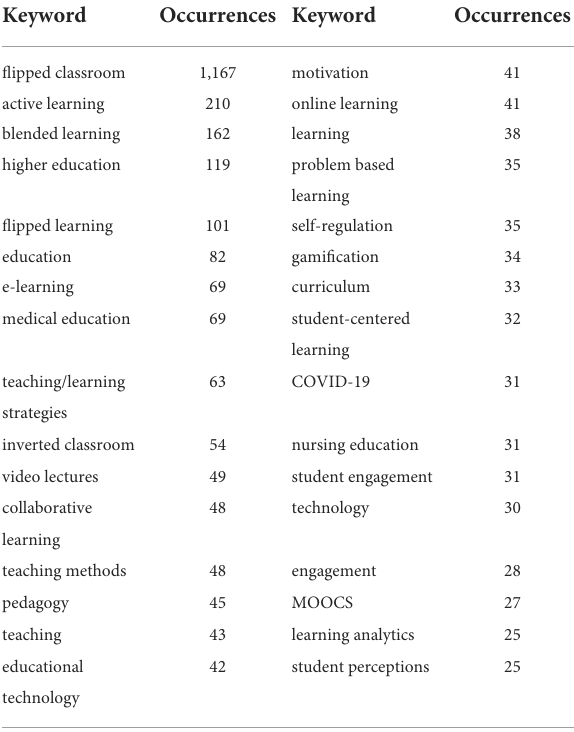
TABLE 6 Concepts that were most repeated in the